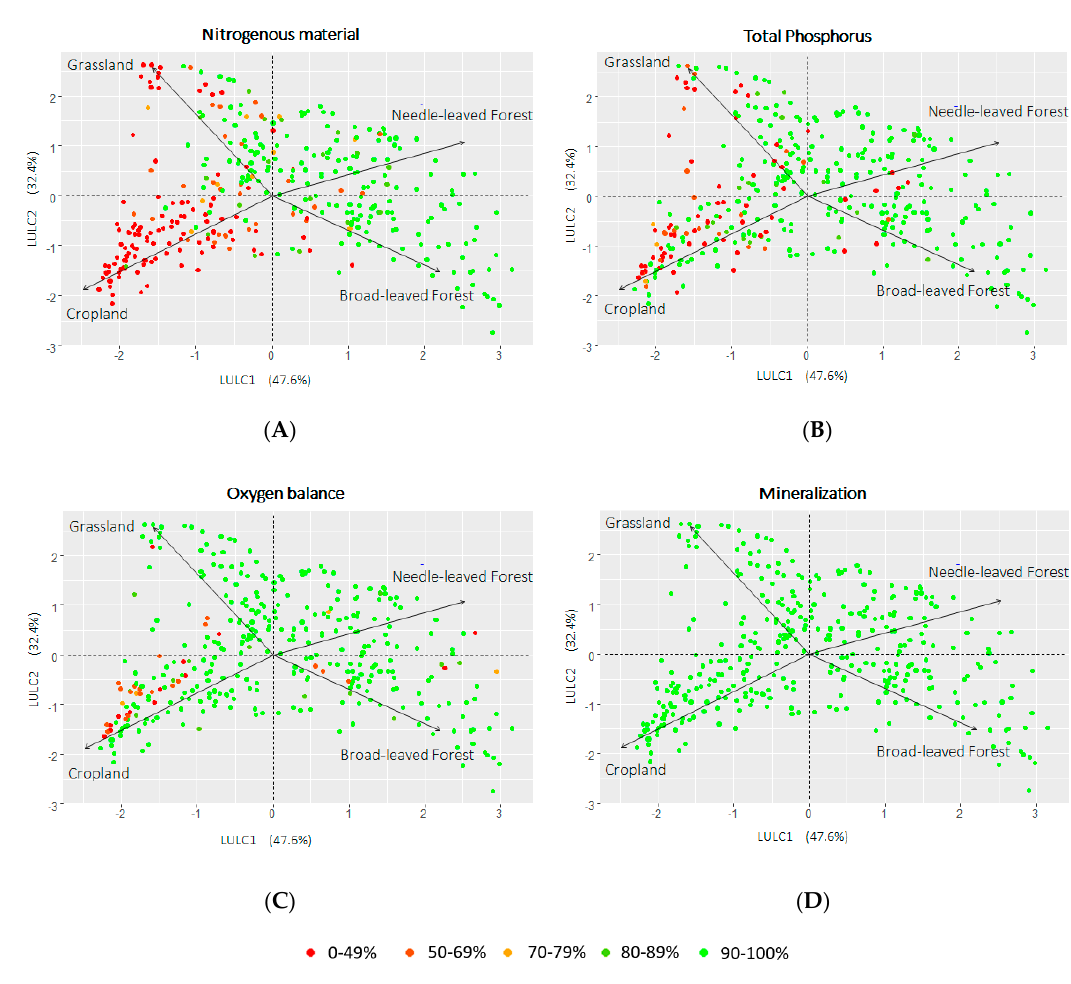
Figure 4. Biplot representing the monitoring stations from a PCA on the main land cover classes in studied sub-catchments. Colors represent the percentage of time the station was classified in “good status” according to current Water Framework Directive standards regarding: ( A ) the “nitrogeneous material” group (i.e., nitrates, nitrites and ammonium); ( B ) total phosphorus; ( C ) the “oxygen balance” group (i.e., dissolved oxygen and dissolved organic carbon) and ( D ) the “mineralization” group (i.e., sulfates and chlorides).